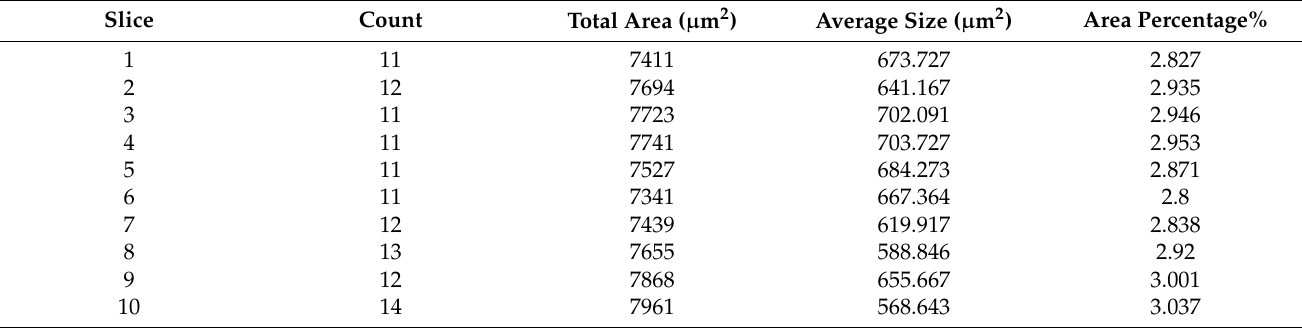
Table 6. Size analysis of segment 3 (mineral 3) in the segmented